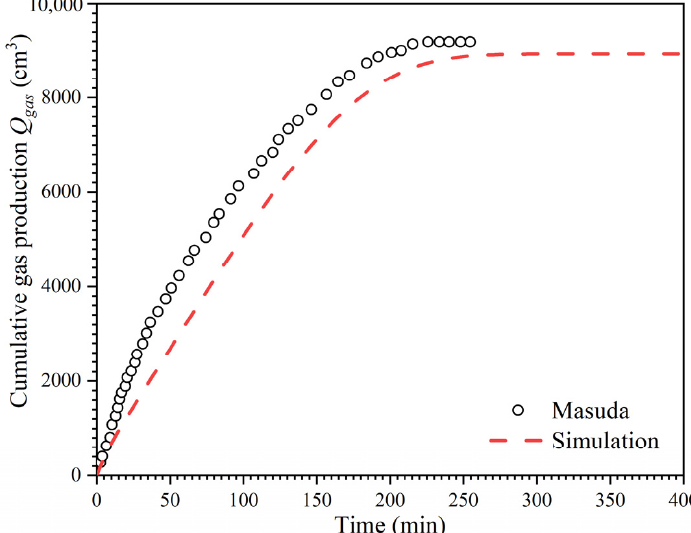
Figure 3. The cumulative gas production by depressurization.